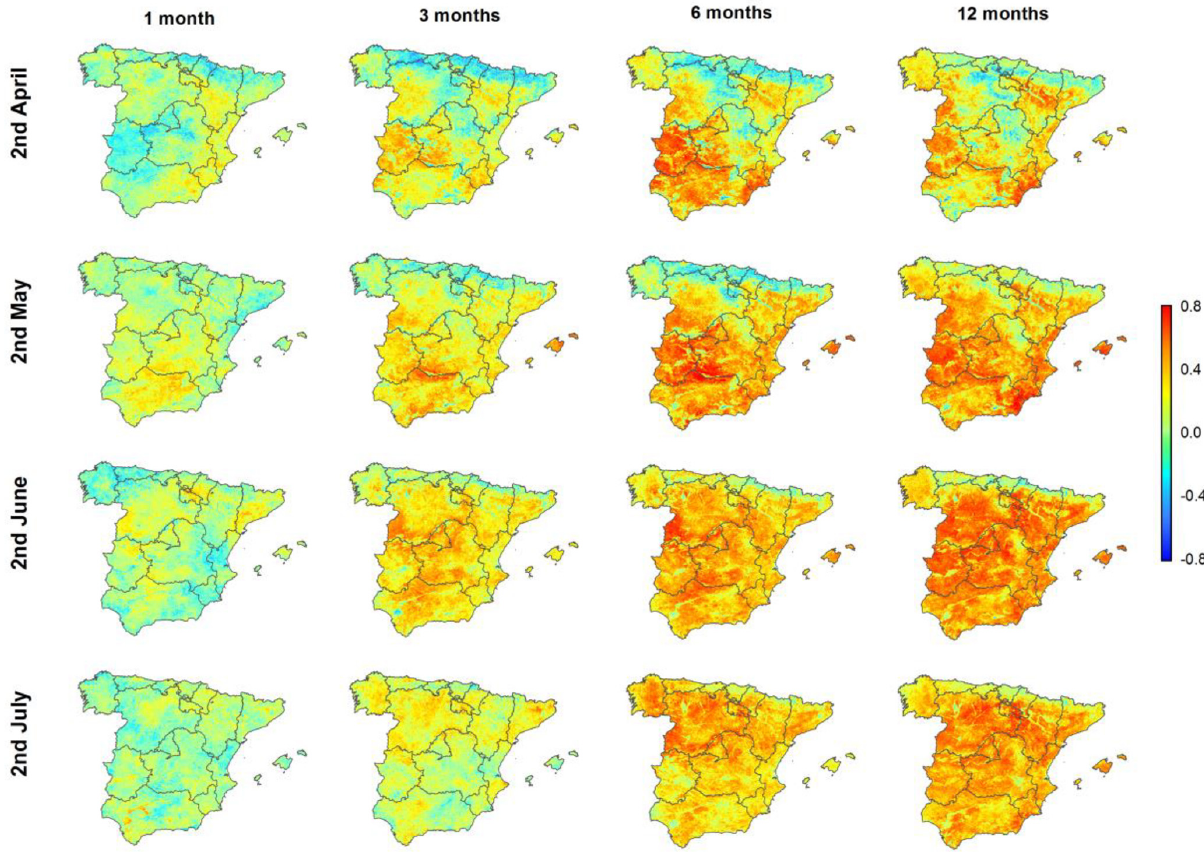
Figure 1. Spatial distribution of the Pearson’s r correlation coefficient calculated between the sNDVI and different SPEI timescales for different semi-monthly